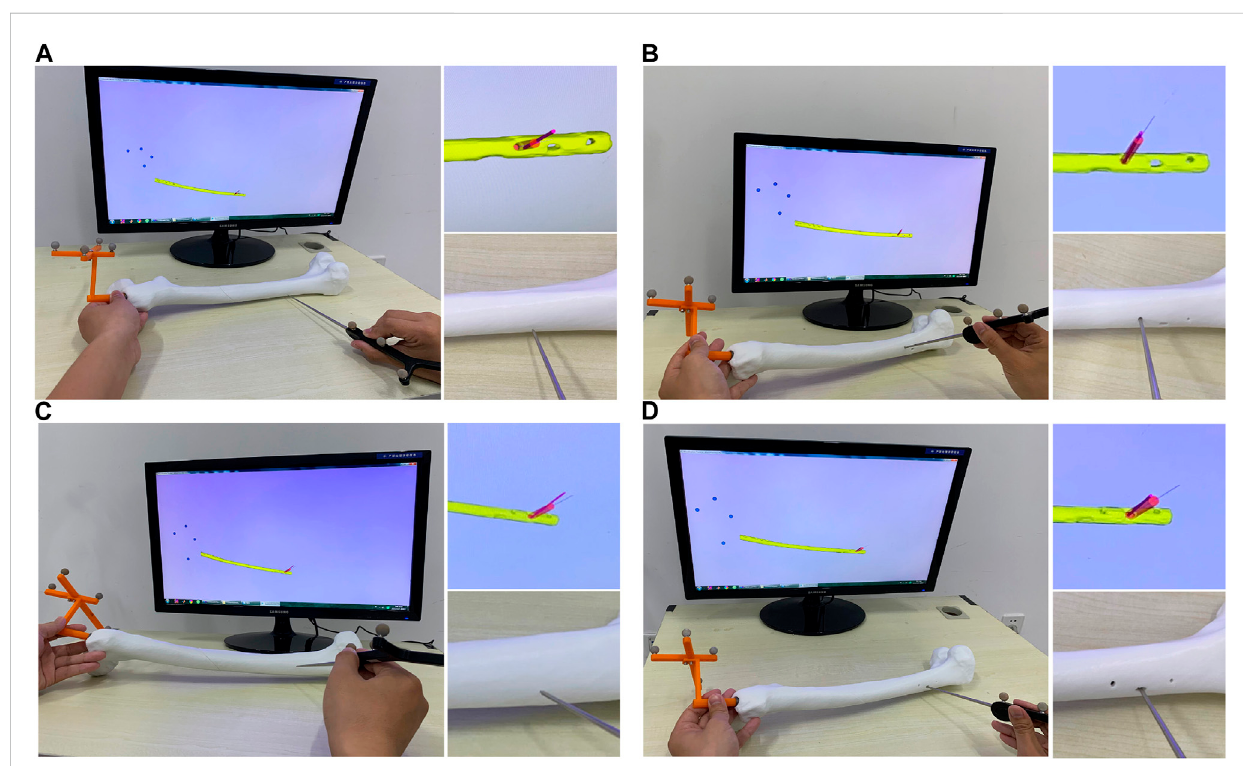
FIGURE 13 Experimental results of positioning of two distal holes. (A) Positioning of the distal hole 1. (B) Drilling of the distal hole 1. (C) Positioning of the distal hole 2. (D) Drilling of the distal hole